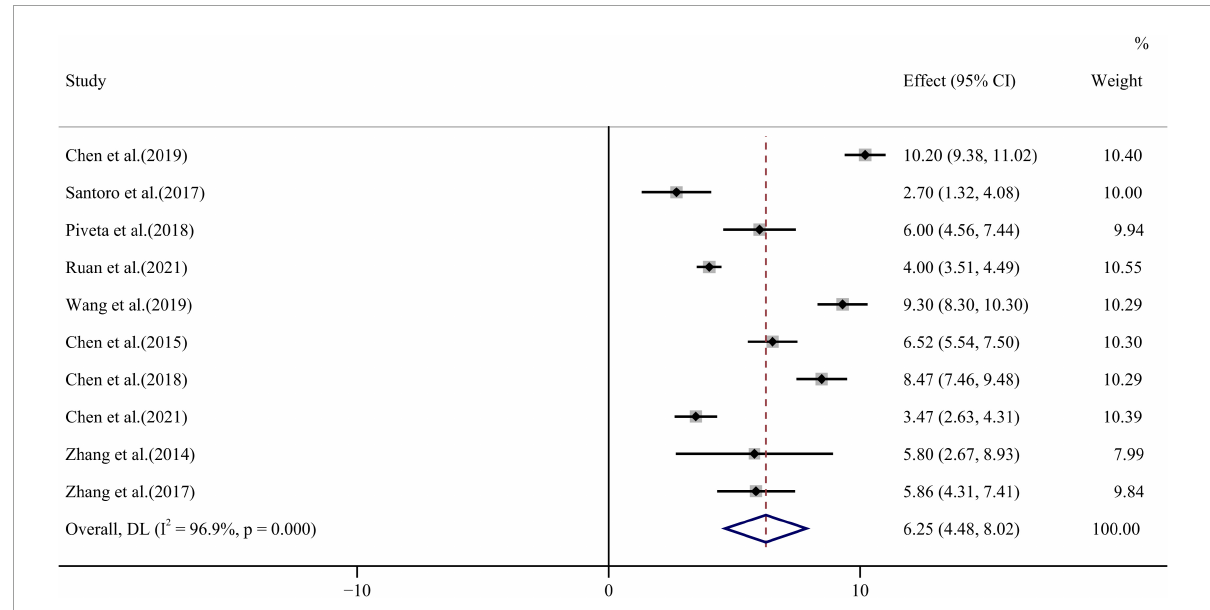
FIGURE8 GAS forest plot [Forest plot of weighted mean difference (WMD) of the association between GAS absolute value reduction and anthracyclines therapy].